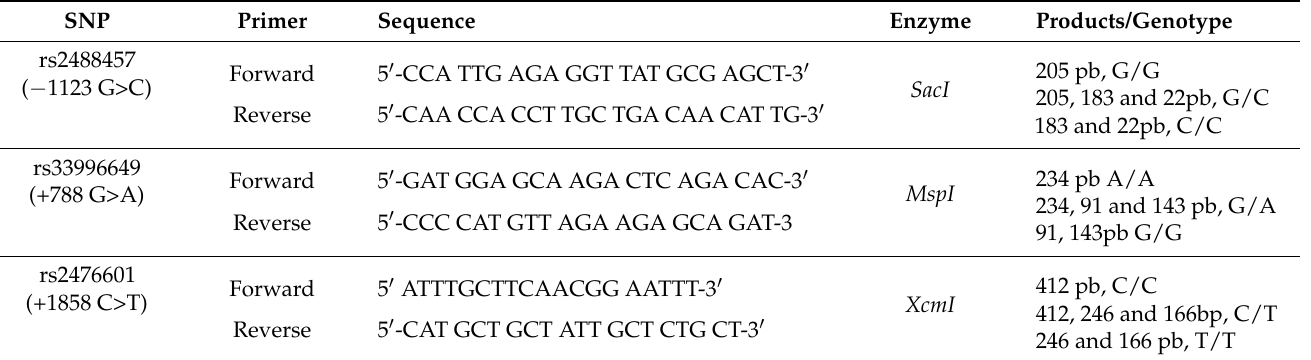
Table 1. Primer sequences for PTPN22 rs2488457G>C, rs33996649G>A and rs2476601C>T